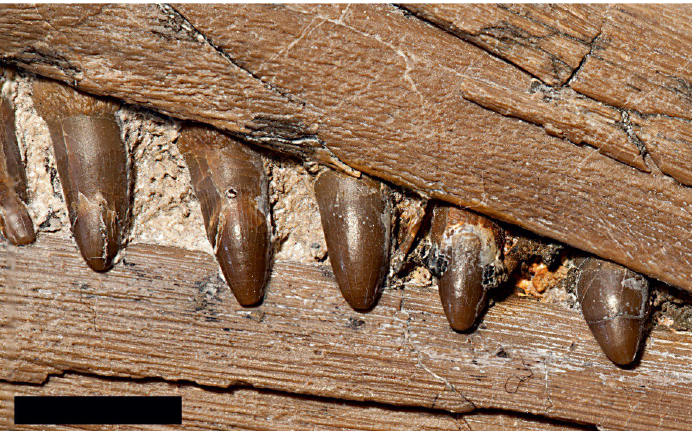
Fig 12. Dentition of Thalassodraco etchesi MJML K 1885, showing smooth enamel. Scale bar 10 mm. Photograph used by permission of the Etches Collection under the CC BY 40 license, original copyright 2016.